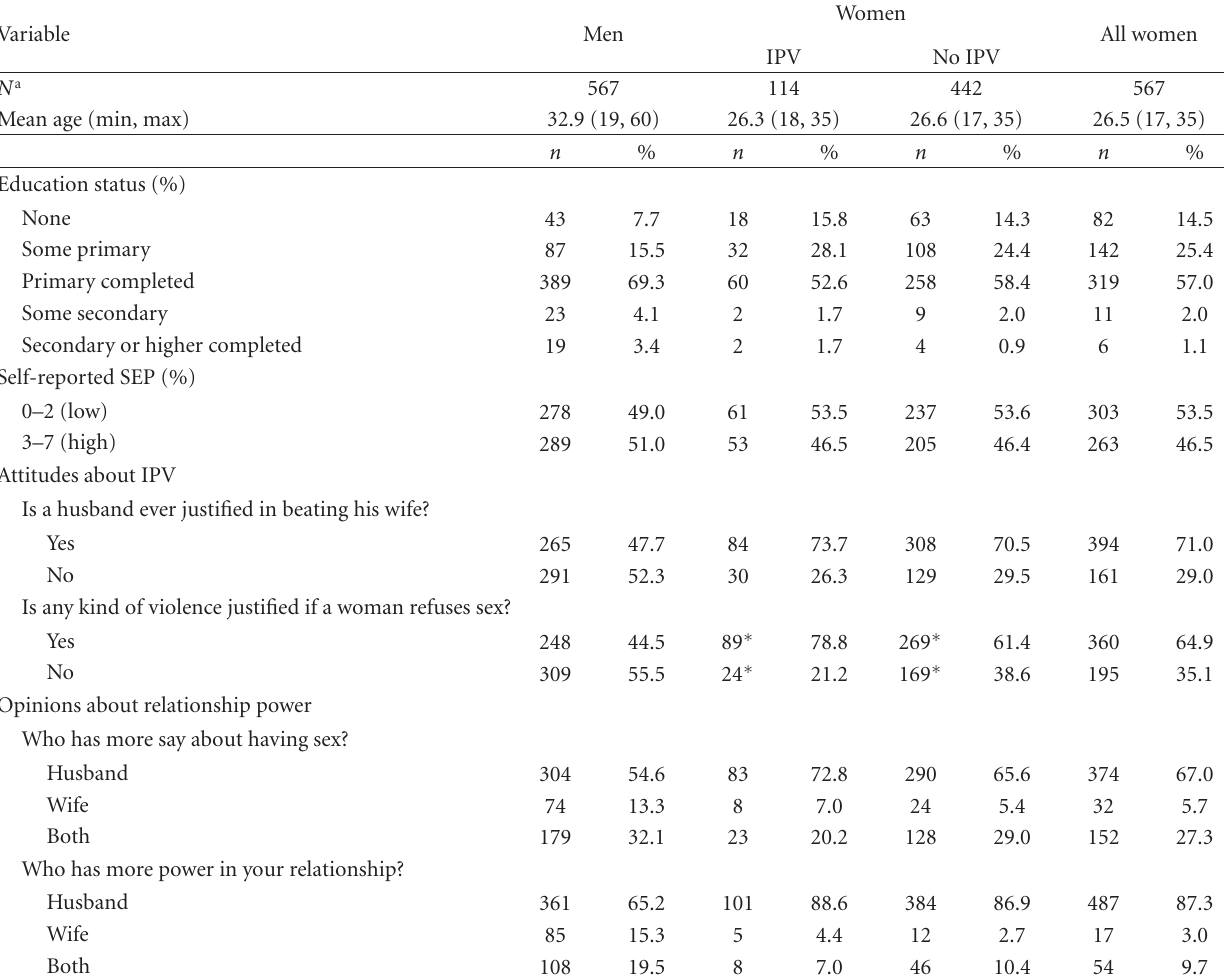
Table 1: Baseline characteristics of couples in the RESPECT